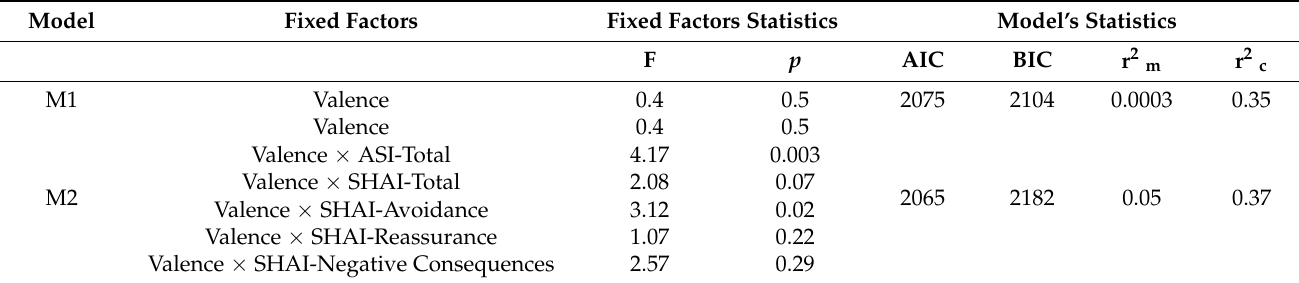
Table 3. M1 investigates the main effect of valence (positive vs. neutral vs. negative) on omission errors. M2 tests the interaction between valence and ASI and SHAI’s subscales scores.